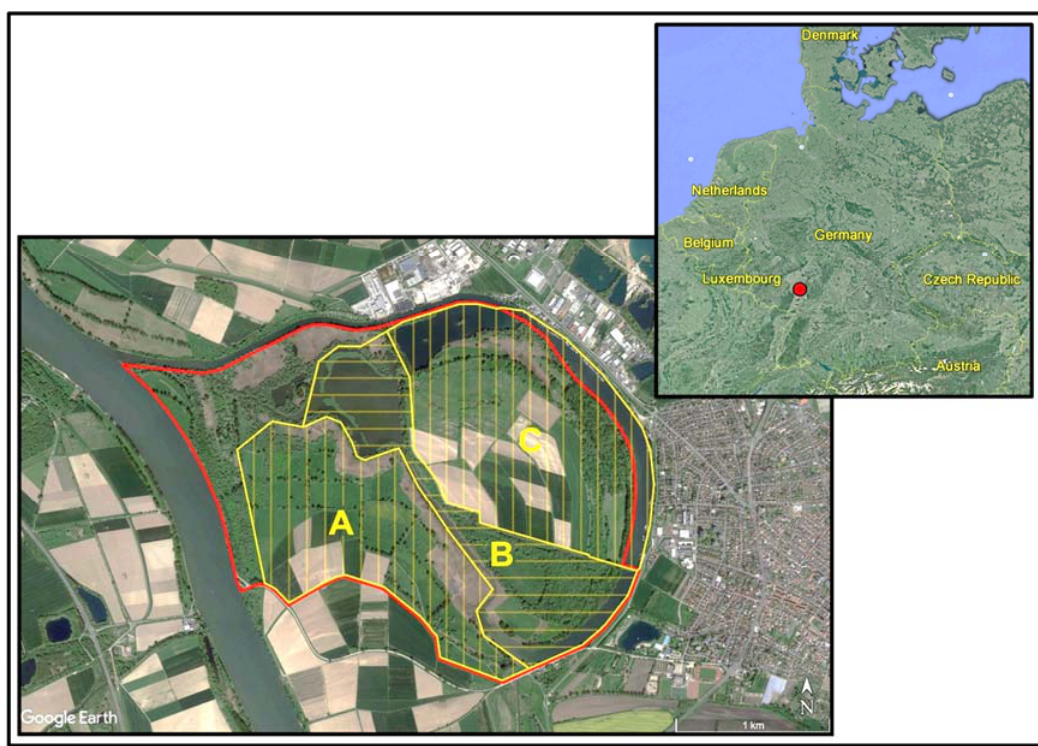
Figure 1. Location and boundaries of the study area “Lampertheimer Altrhein”. The red line marks the border of the nature conservation area; the yellow line marks the borders of the study site, which was divided into three subareas A, B, C. A 1 km distance bar is shown at the lower left side of the map.